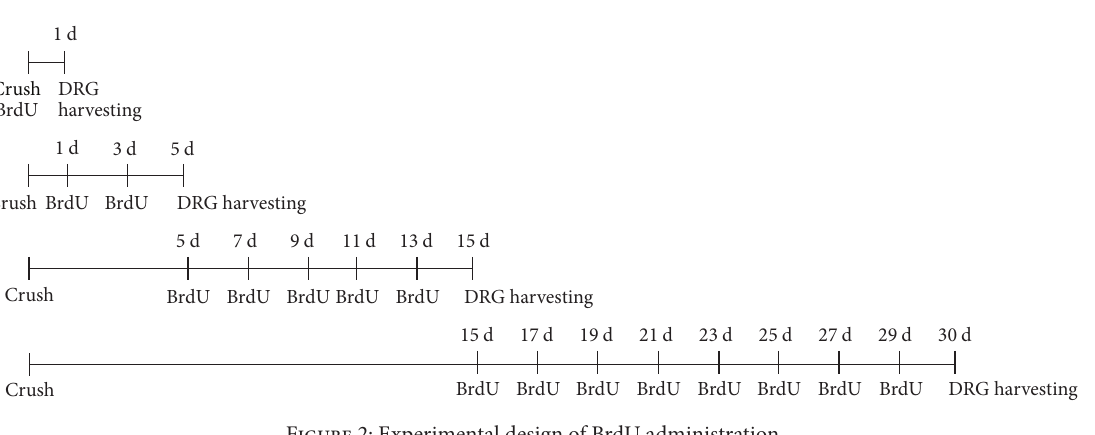
Figure 1: Example of the toluidine blue stained micrographs of reference (a) and counting (b) sections from which neurons numbers are estimated using the physical disector. All nuclear profiles are recognized in the reference section (yellow circles); nuclear profiles that do not appear in the counting section are counted (green circles). The nuclei of cells that appear in both the counting and reference sections are not counted (red circles). Bars = 50 𝜇 m.